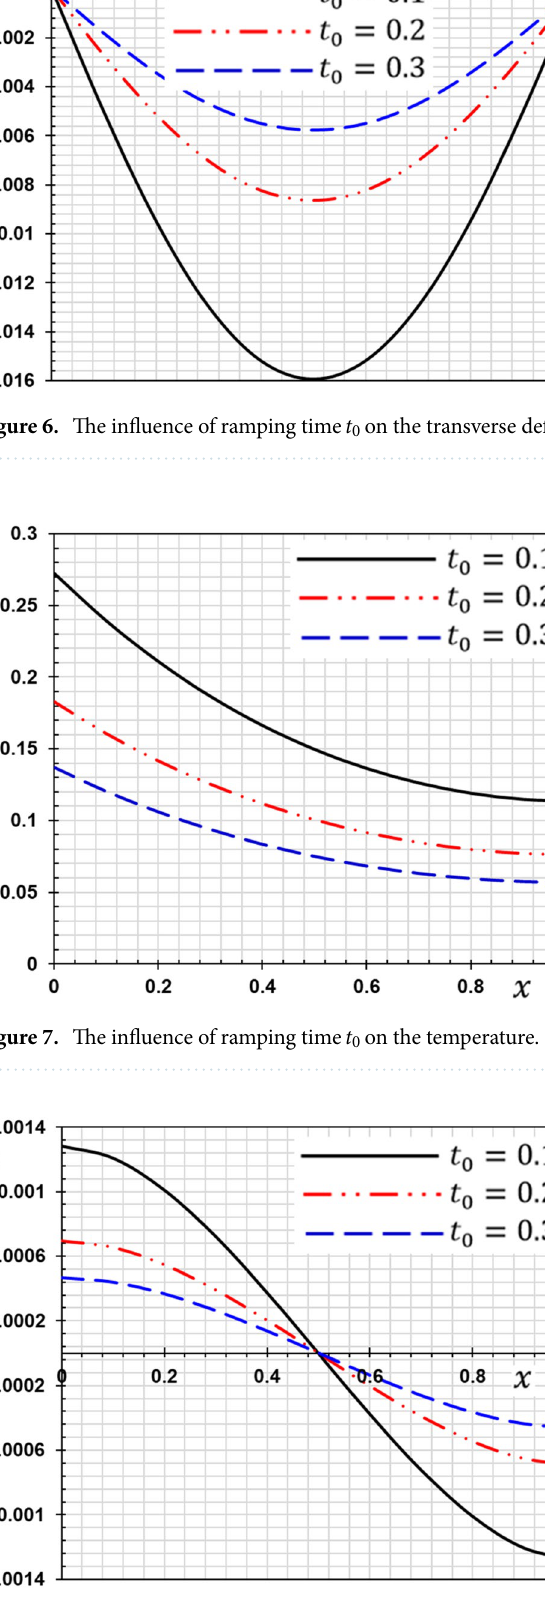
Figure 8. The influence of ramping time t 0 on the